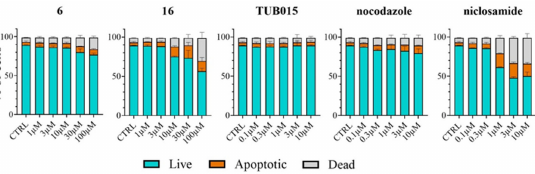
Figure 8. Percentages of live (cyan), apoptotic (orange), and dead (light grey) peripheral blood mononuclear cells (PBMC) after treatment for 72 h with compounds as 6 , 16 , TUB015, nocodazole, and niclosamide at the indicated concentration points. Results are reported as mean ± SD of two ( n = 2)